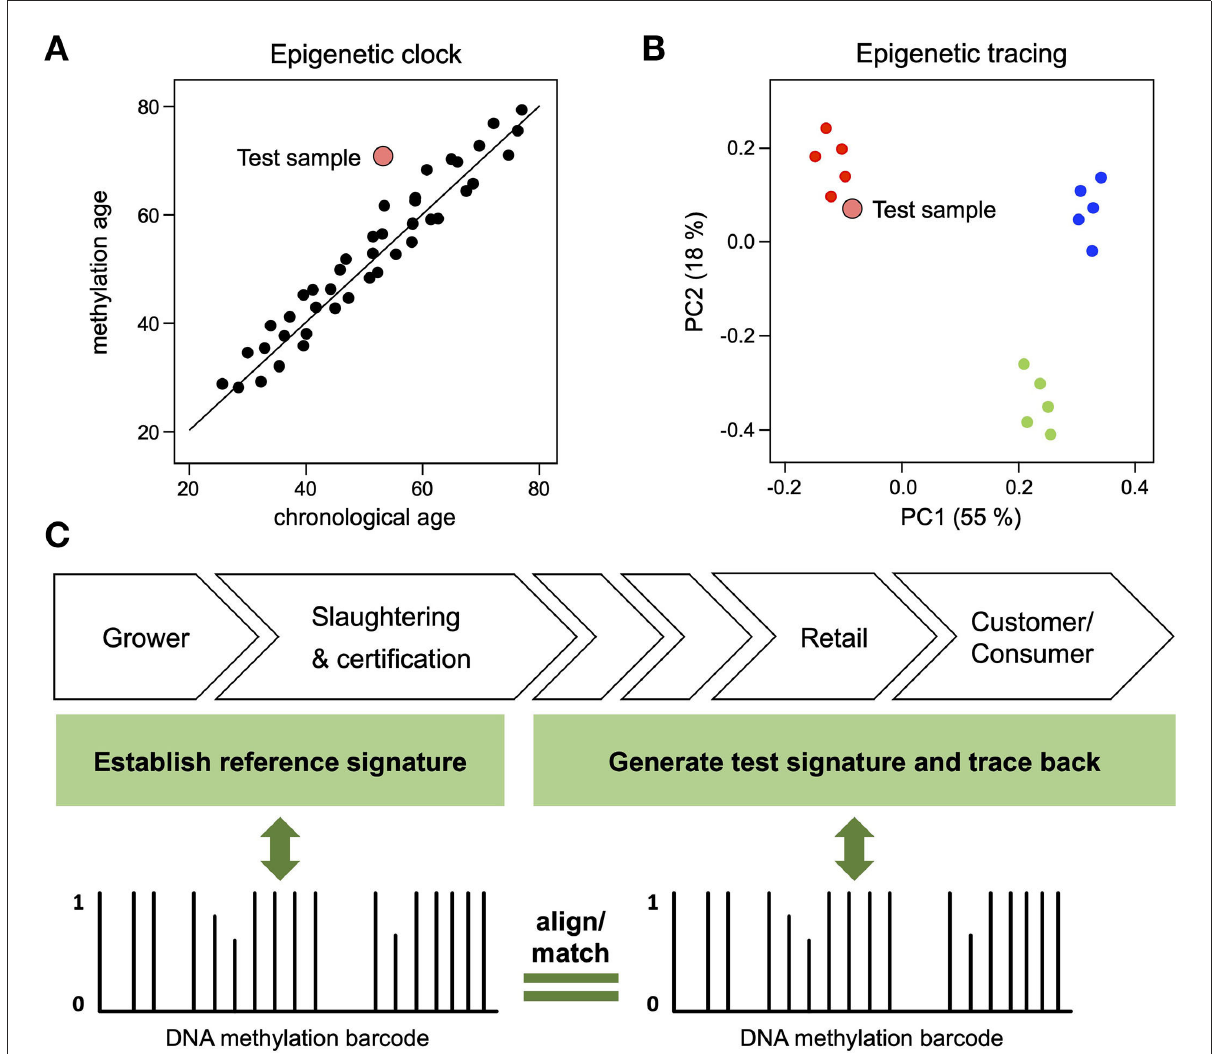
FIGURE2 Compound DNA methylation biomarkers for animal welfare assessments. (A) DNA methylation analysis of a test sample (large red dot) reveals a methylation age that is higher than its chronological age, indicating that the corresponding individual was exposed to unhealthy conditions. (B) DNA methylation analysis of a test sample (large red dot) reveals a pattern that is similar to the reference samples provided by one specific farm (small red dots), thus pinpointing its origin from a source with high welfare standards. (C) Illustration of epigenetic tracing by environmental fingerprinting. Meat samples are collected on farms and/or at slaughterhouses for the establishment of reference DNA methylation signatures (“barcodes”). Test signatures can be generated from any point along the value chain and then be aligned with reference signatures. Test signatures matching a specific reference signature confirm that the animals were reared in the specific reference farm(s). Conversely, test signatures not aligning with a reference signature indicate that the animal was reared outside of the farms represented by the reference